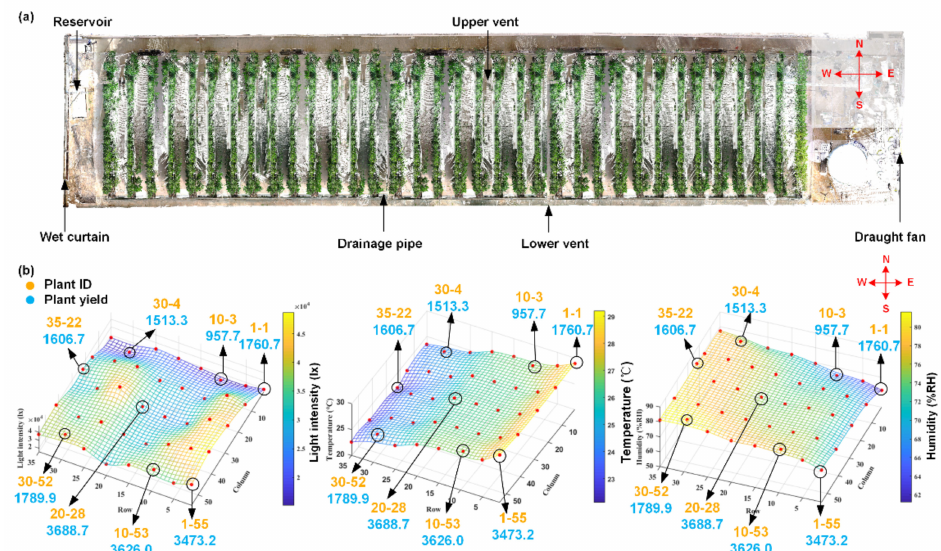
Figure 2. The plant scenario in the greenhouse. ( a ) Top view of the greenhouse and the locations of draught fans, reservoirs, wet curtains, drainage pipes, and vents. ( b ) The environmental parameters vary in different locations with light intensity changes ( left ), temperature changes ( middle ), and humidity changes ( right ). The yield for each individual tomato plant is also